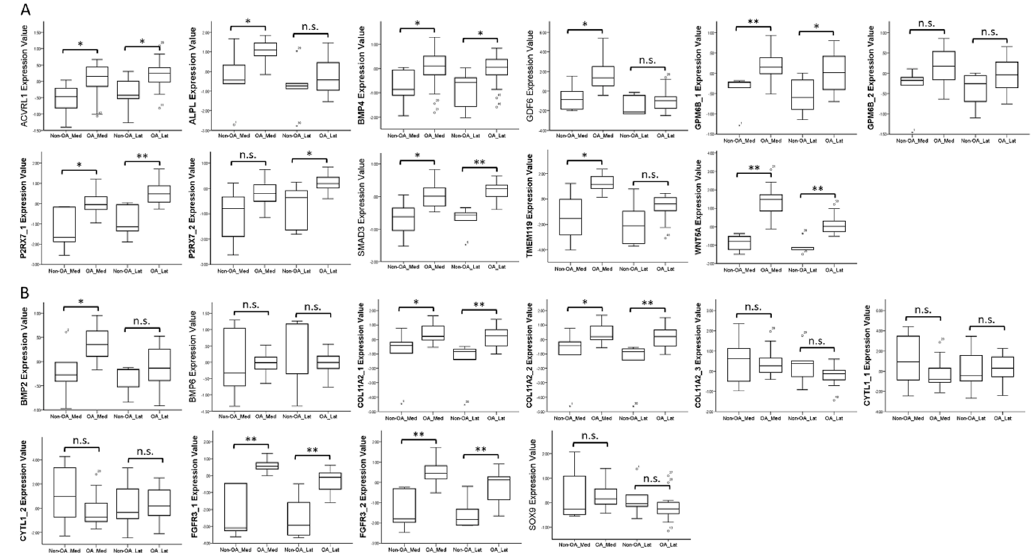
Figure 3. Expression patterns of genes related to biological processes of OA in GEO array of OA knee subchondral bone. The expression patterns of ( A ) nine up-regulated genes and ( B ) six down-regulated genes related to the biological processes of cellular, tissue and structural changes in OA were analyzed in a GEO array of normal and OA knee subchondral bone (GSE51588). ACVRL1 , BMP4 , SMAD3 , and WNT5A were significantly up-regulated in both medial and lateral plateaus, whereas ALPL , GDF6 , and TMEM119 were significantly up-regulated only in the medial plateau of OA knees. The expression patterns of BMP2 , COL11A2 , and FGFR3 (up-regulated) in subchondral bones of OA knees were different from that identified in our expression profile of OA knee chondrocytes (down-regulated). * indicated p < 0.05, ** indicated p < 0.01, and n.s. indicated no